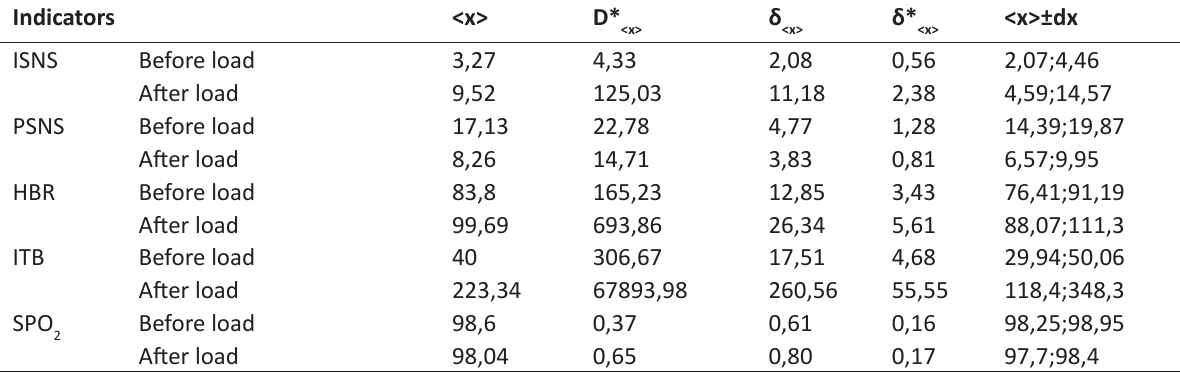
Table 1 . Cardio-respiratory indicators of 1 st group girls’ functional system after physical load